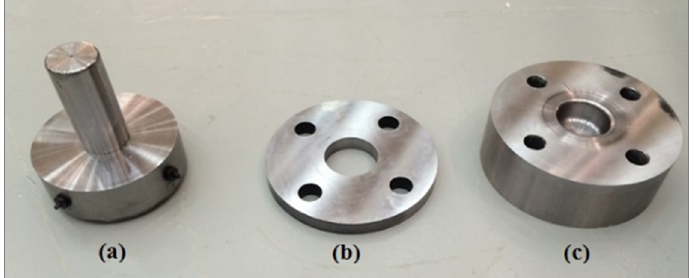
Figure 13. The die set for the deep drawing process: ( a ) punch, ( b ) blank holder, and ( c ) die.